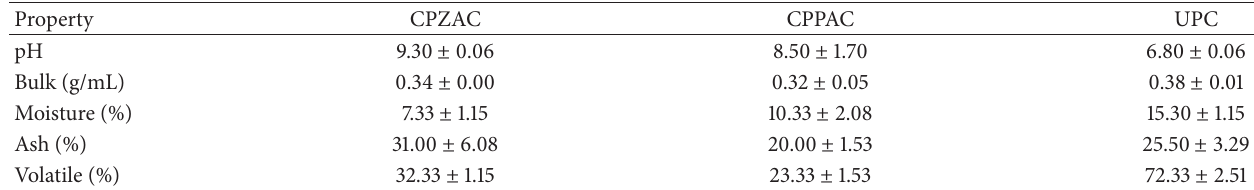
Table 1: Physical characteristics of carbon samples.